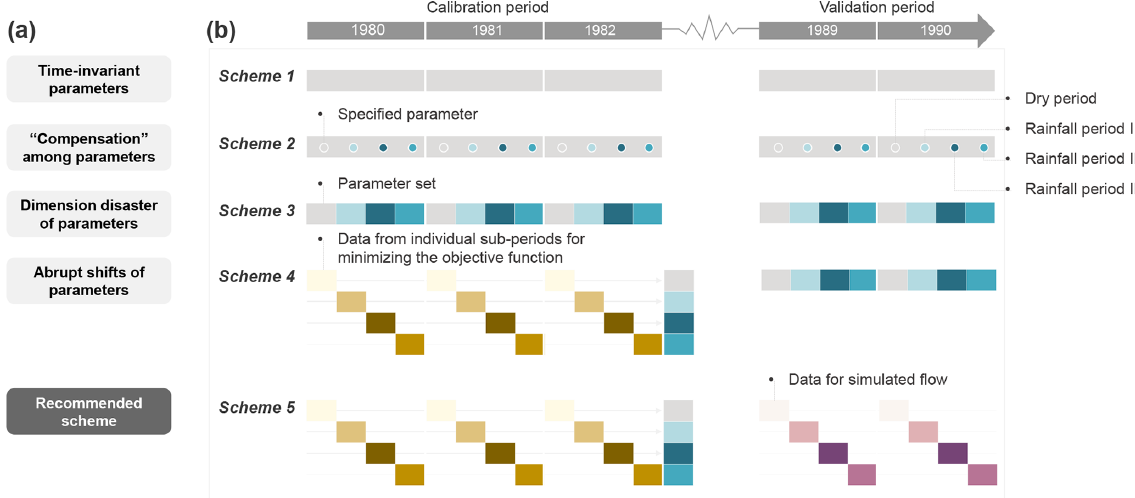
Figure 2. Calibration schemes. (a) Objectives of the schemes. (b) Schematic illustration of the five schemes. Note that in scheme 1, the parameters are time-invariant; in scheme 2, the dynamic of only the specific parameter is operated. The specific parameters in different sub-periods and the other fixed parameters are optimized simultaneously; in scheme 3, the parameter set is dynamized. The parameter sets in different sub-periods are optimized simultaneously; in scheme 4, only the data from the individual sub-periods are used for minimizing the objective function, while the model is run for the whole period. The parameter sets in different sub-periods are optimized. In the validation period, the parameter set between two consecutive sub-periods is updated accordingly. In scheme 5, the calibration is the same as in scheme 4. In the validation period, the simulated flow data from each separate sub-period are combined and compared with the observed